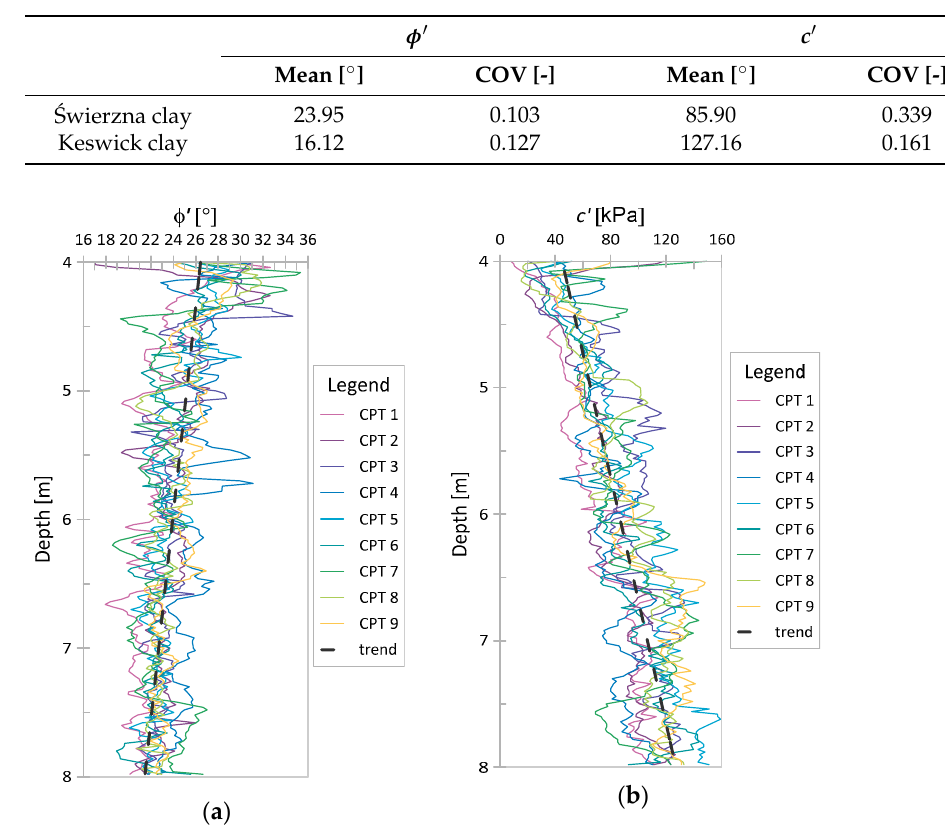
Figure 12. MoE results for ´Swierzna clay: ( a ) φ (cid:48) ; ( b ) c (cid:48) Figure 12 . MoE results for Ś wierzna clay: ( a ) ϕ ′ ; ( b ) c ′ .